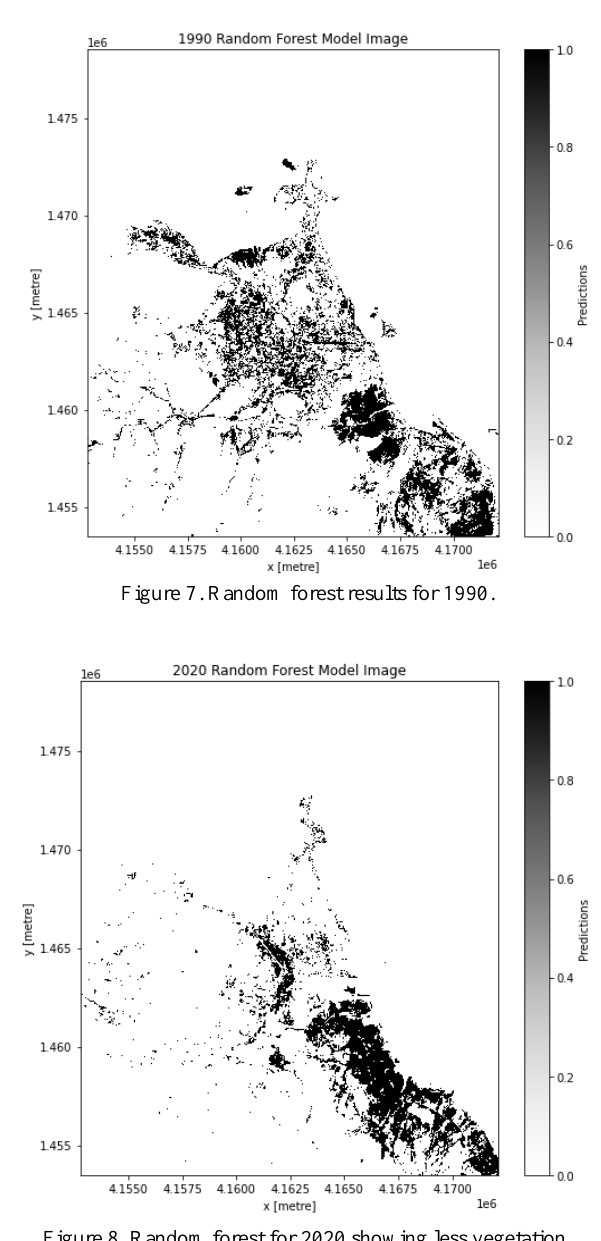
Figure 8. Random forest for 2020 showing less